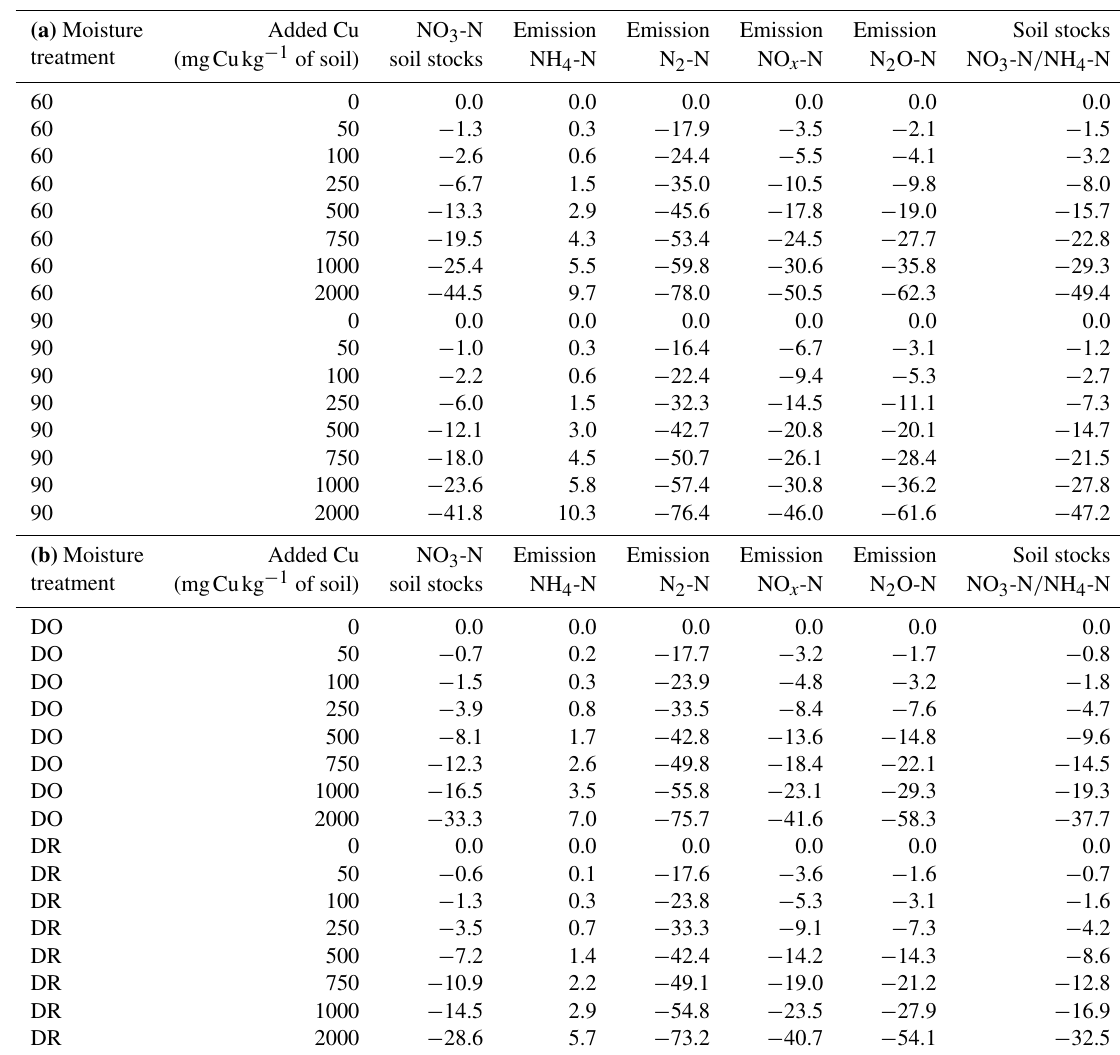
Table 2. Percentage of variation in soil NO 3 -N stocks; soil NO 3 -N / NH 4 -N stocks; and NH 4 -N, N 2 -N, NO x -N and N 2 O-N emissions in response to soil [Cu] in the various initial incubation treatments for a 3d